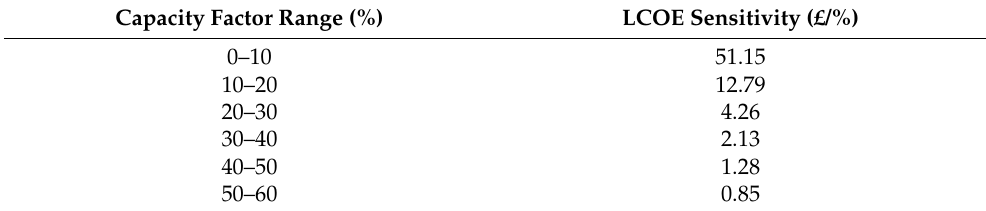
Table 13. LCOE Sensitivity.